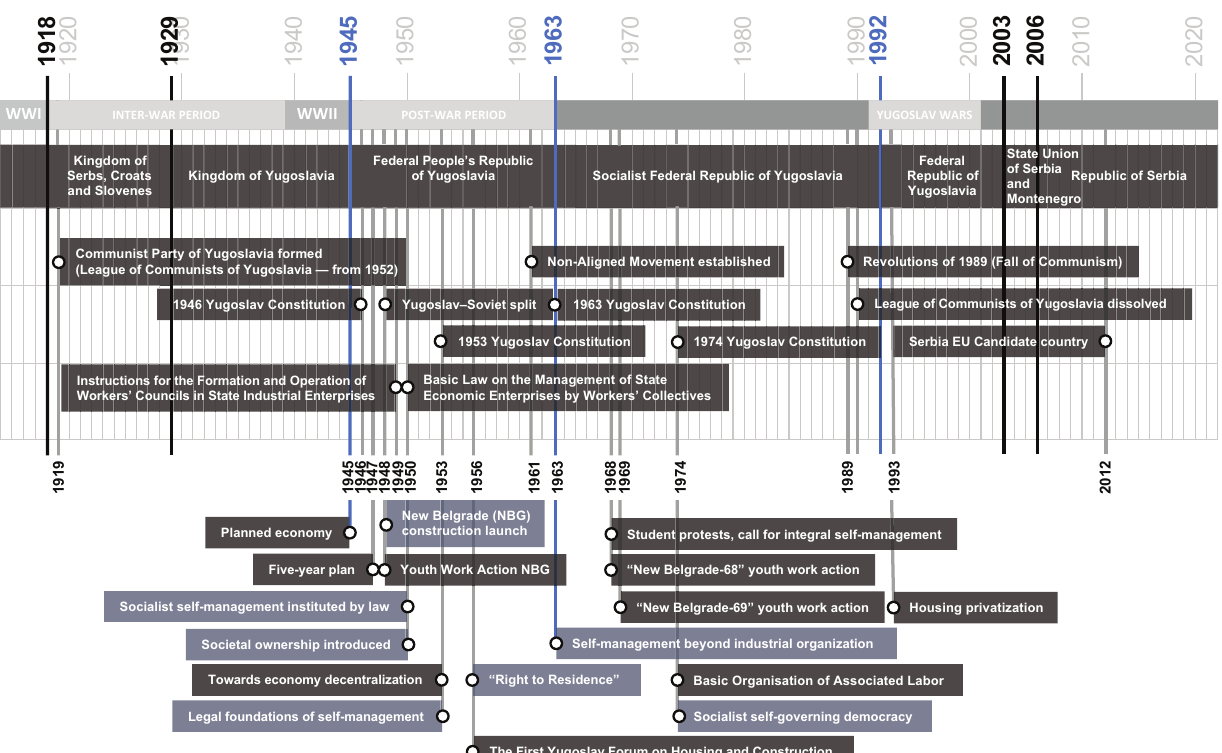
Figure 2. Timeline of historical events and policies related to the emergence of key ownership and management concepts. Source: Anica